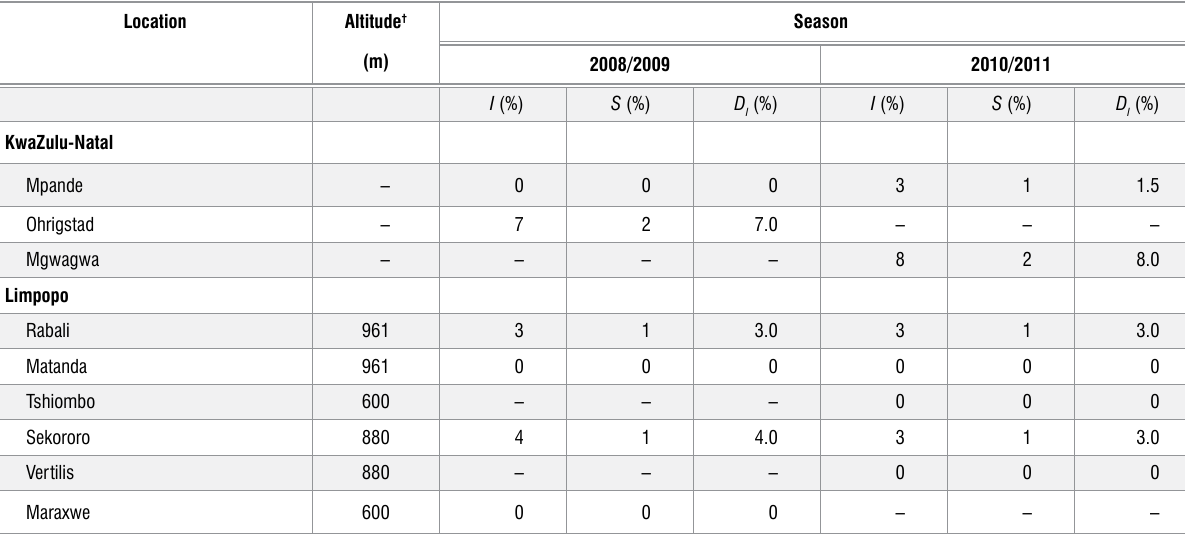
Occurrence of bacterial brown spot in dry bean subsistence farms of South